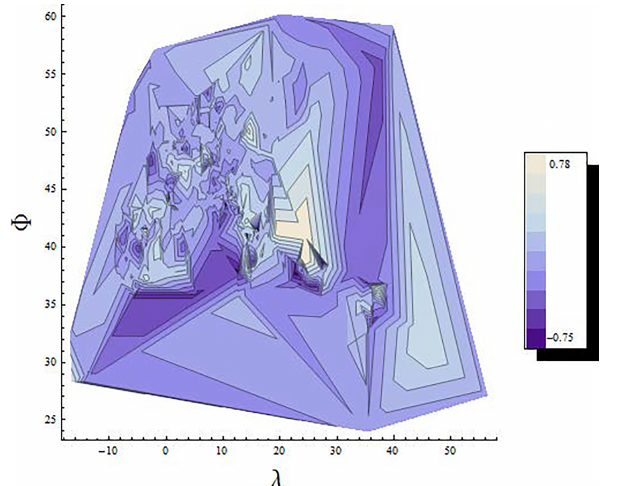
Figure 10. Latitude difference plot for each location set. The axes are contemporary latitude and longitude.